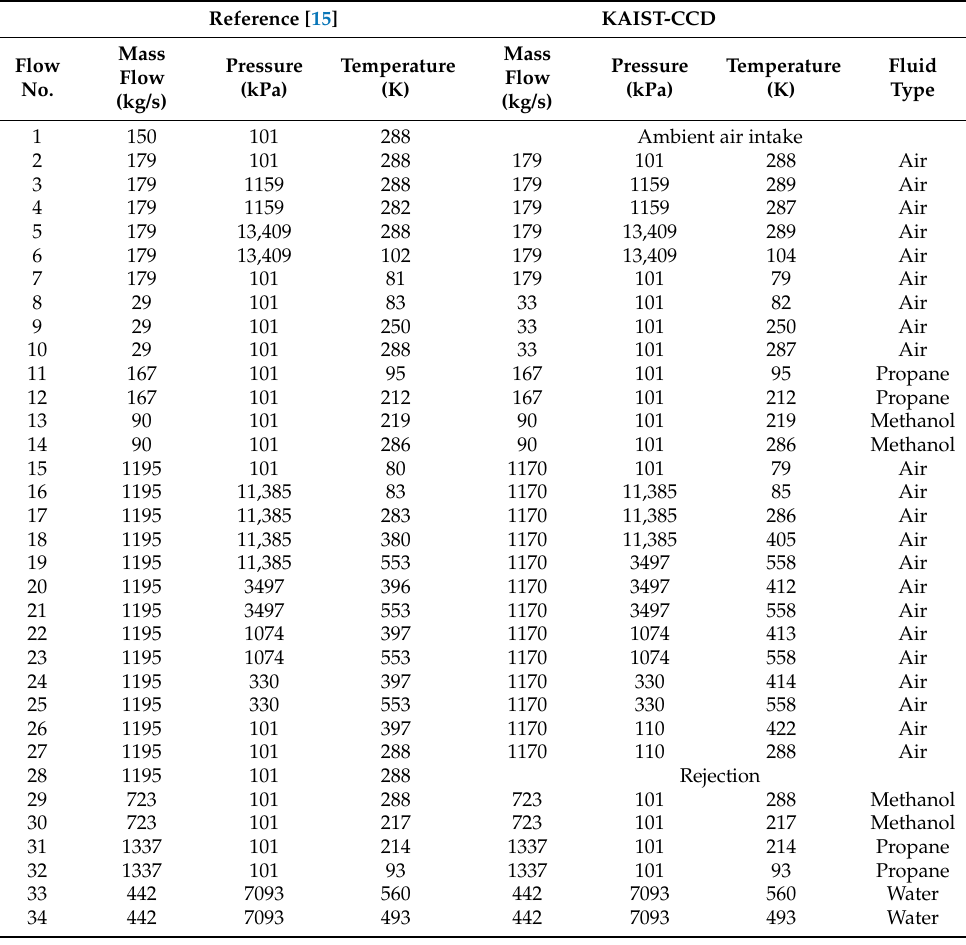
Table 3. The main steam parameter for reference data from [15] (left) and KAIST-CCD (right). Reference [15] KAIST-CCD Flow